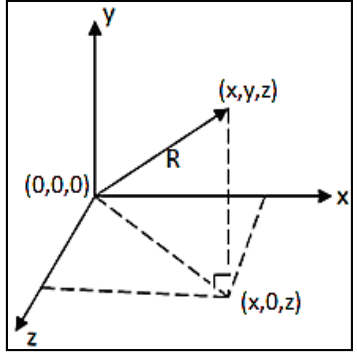
Figure 5. The combination of x, y and z vectors in three axis acceleration.